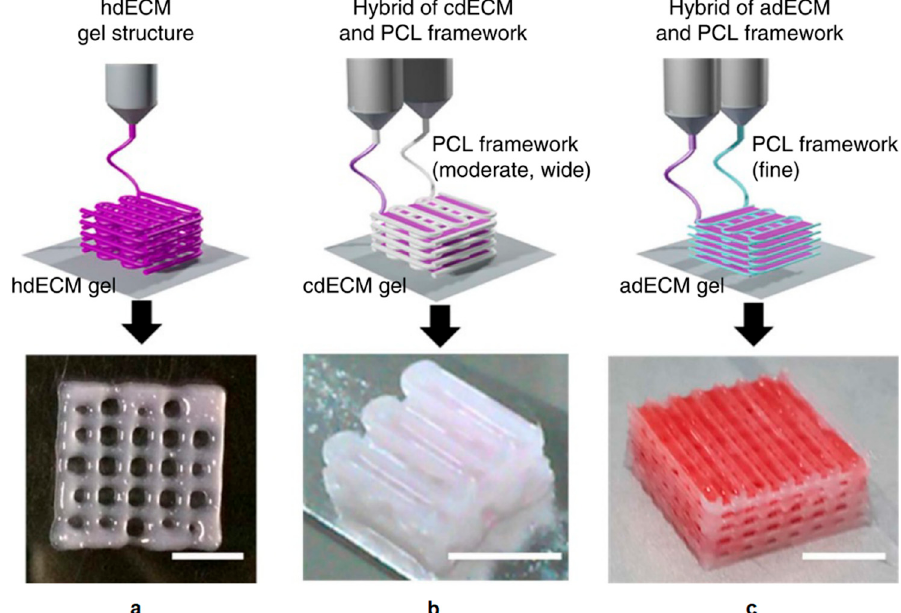
Figure 6. ( a ) Bioprinted heart tissue with only the heart dECM (hdECM). ( b ) Printed cartilage tissue with cartilage dECM (cdECM) and PCL framework. ( c ) Printed adipose tissue with adipose dECM (adECM) and PCL framework (scale bar, 5 mm). Reproduced with open access from F. Pati et al., Nature Communications; published by Nature Publishing Group, 2014 [116].